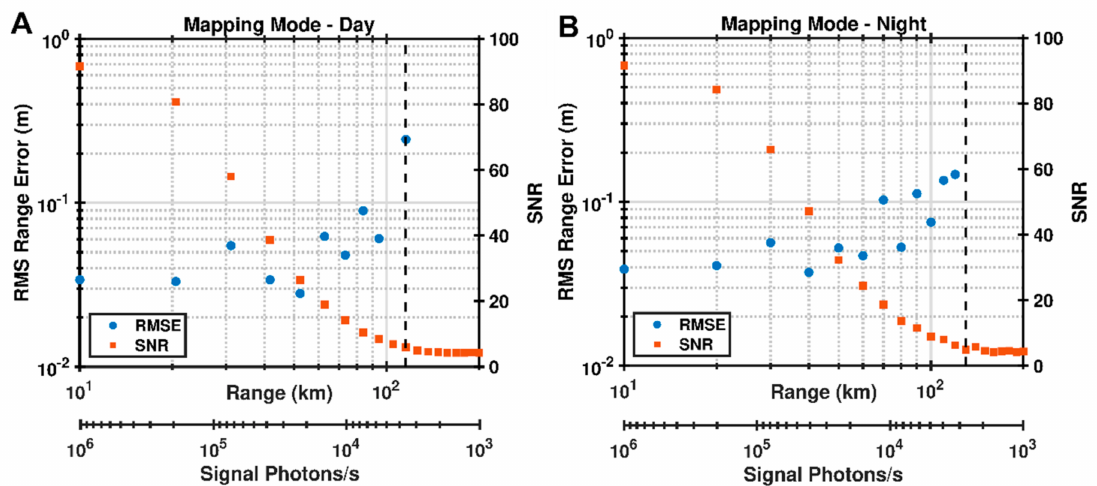
Figure 12. Simulation results of SALi ranging performance as a function of target range for the SALi Mapping mode under ( A ) daytime and ( B ) nighttime conditions following the conventions of Figure 10. The simulation assumed a flat surface (no range